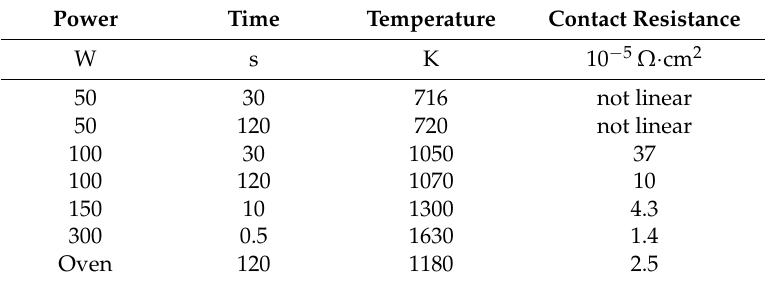
Table 1. Overview of irradiation